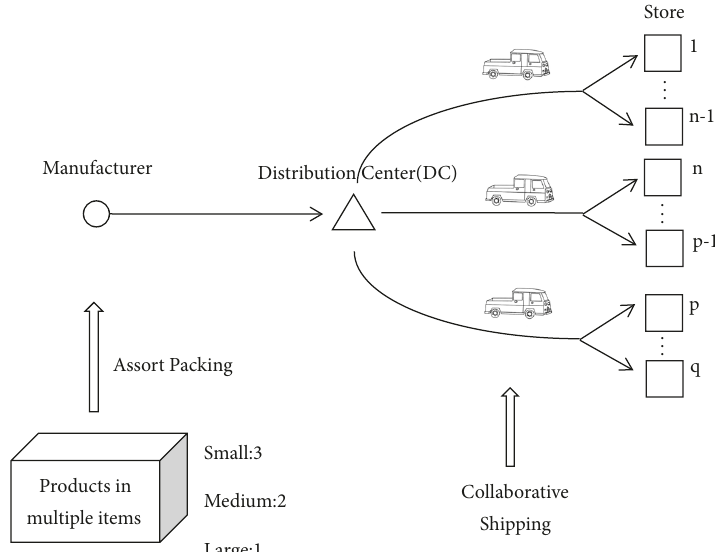
Figure 1: Fashion clothing supply chain